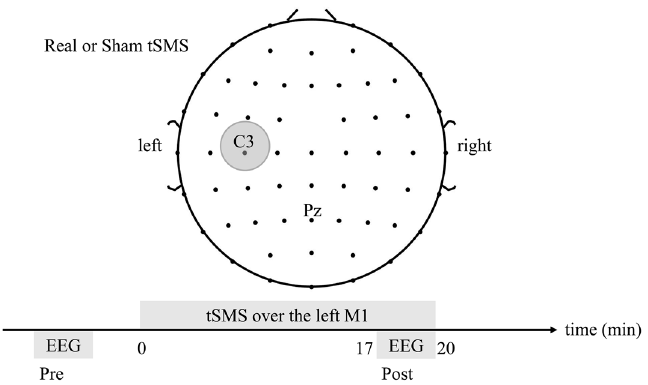
Figure 1. Schematic illustration of the experimental setup. Real or sham tSMS (grey circle) was applied over the left M1 for 20 min. The resting EEG was recorded for 3 min before and during the intervention (Pre and Post respectively).